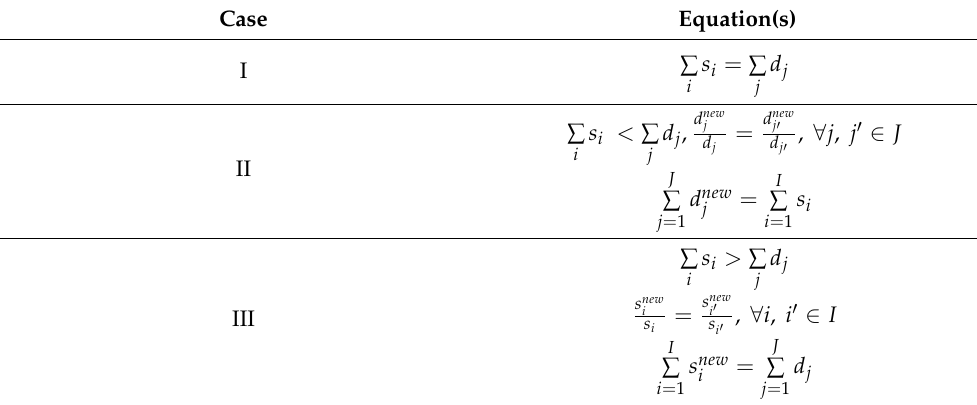
Table 2. Different possible cases when solving the transportation problem.